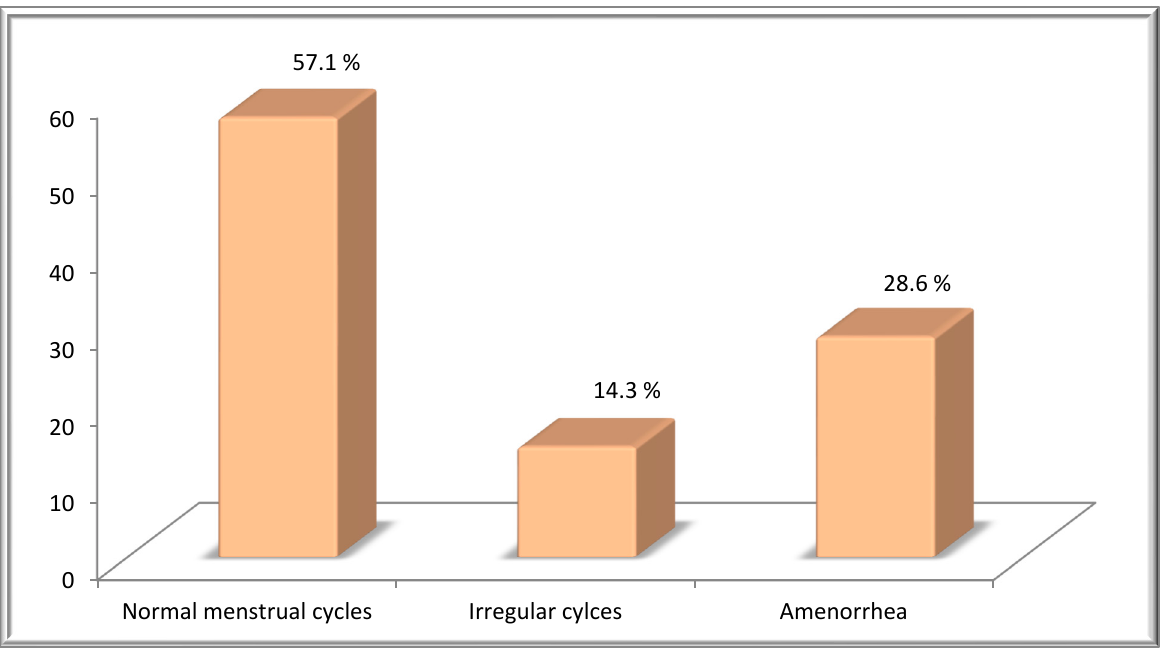
Figure 5. Distribution of HD patients according to menstrual status following BEACOPP treatment.